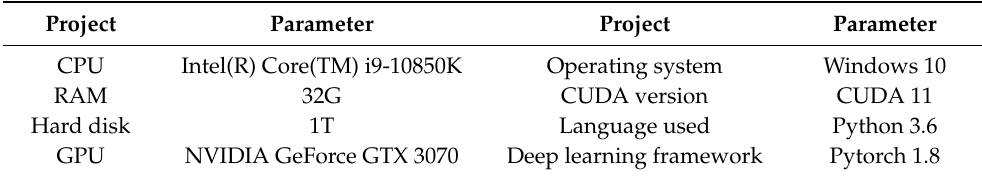
Table 2. Hardware and software configuration.